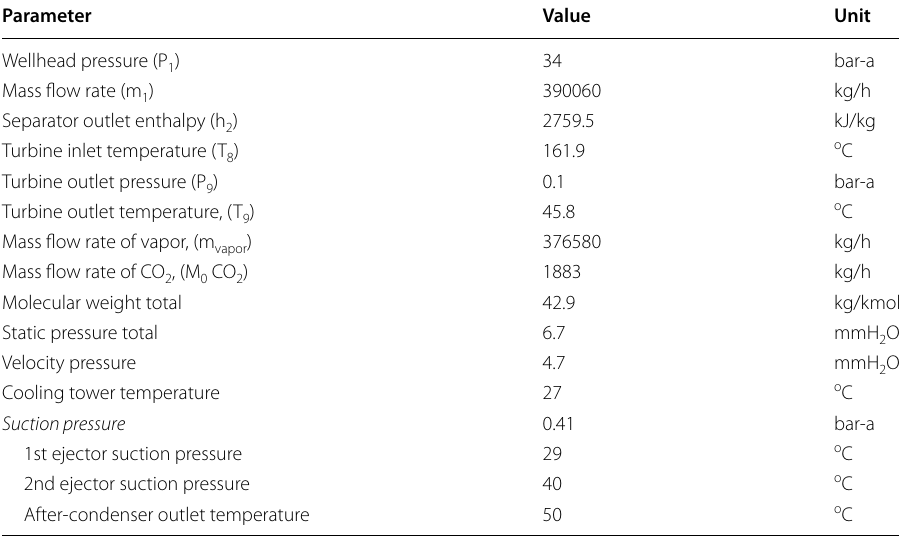
Table 1 Data and assumptions of Kamojang GPP Units 2 and